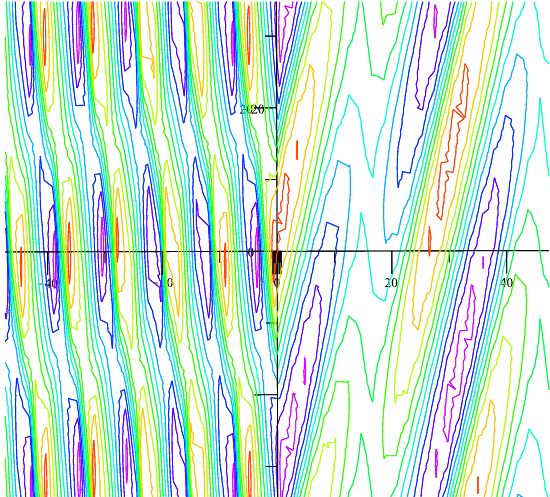
Figure 12. Contour map of H field with the incident angle θ i = 16 ◦ at the interface between the vacuum ( x < 0) and effective double negative material ( x > 0) when ω p t =